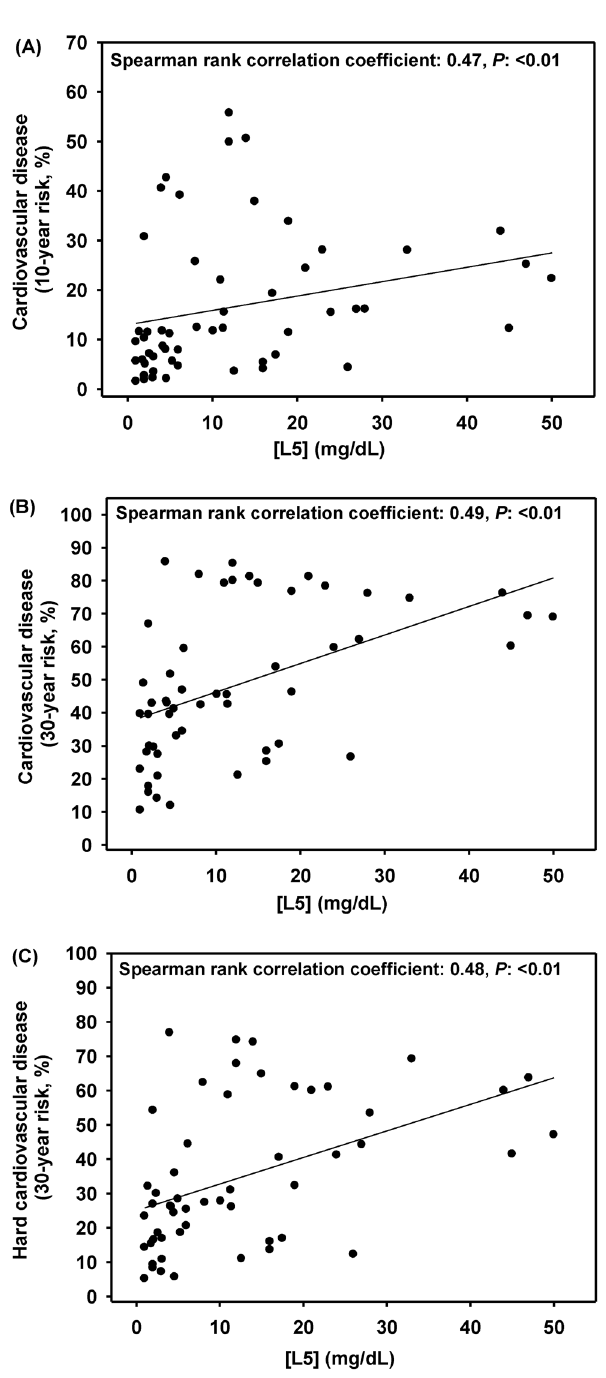
Figure 4. Correlation between L5 concentration ([L5]) and cardiovascular disease (CVD) risks. L5 concentration values are plotted against each risk as indicated. Correlation between [L5] and (A) 10-year general CVD risk, (B) 30-year general CVD risk, and (C) 30-year hard CVD risk.